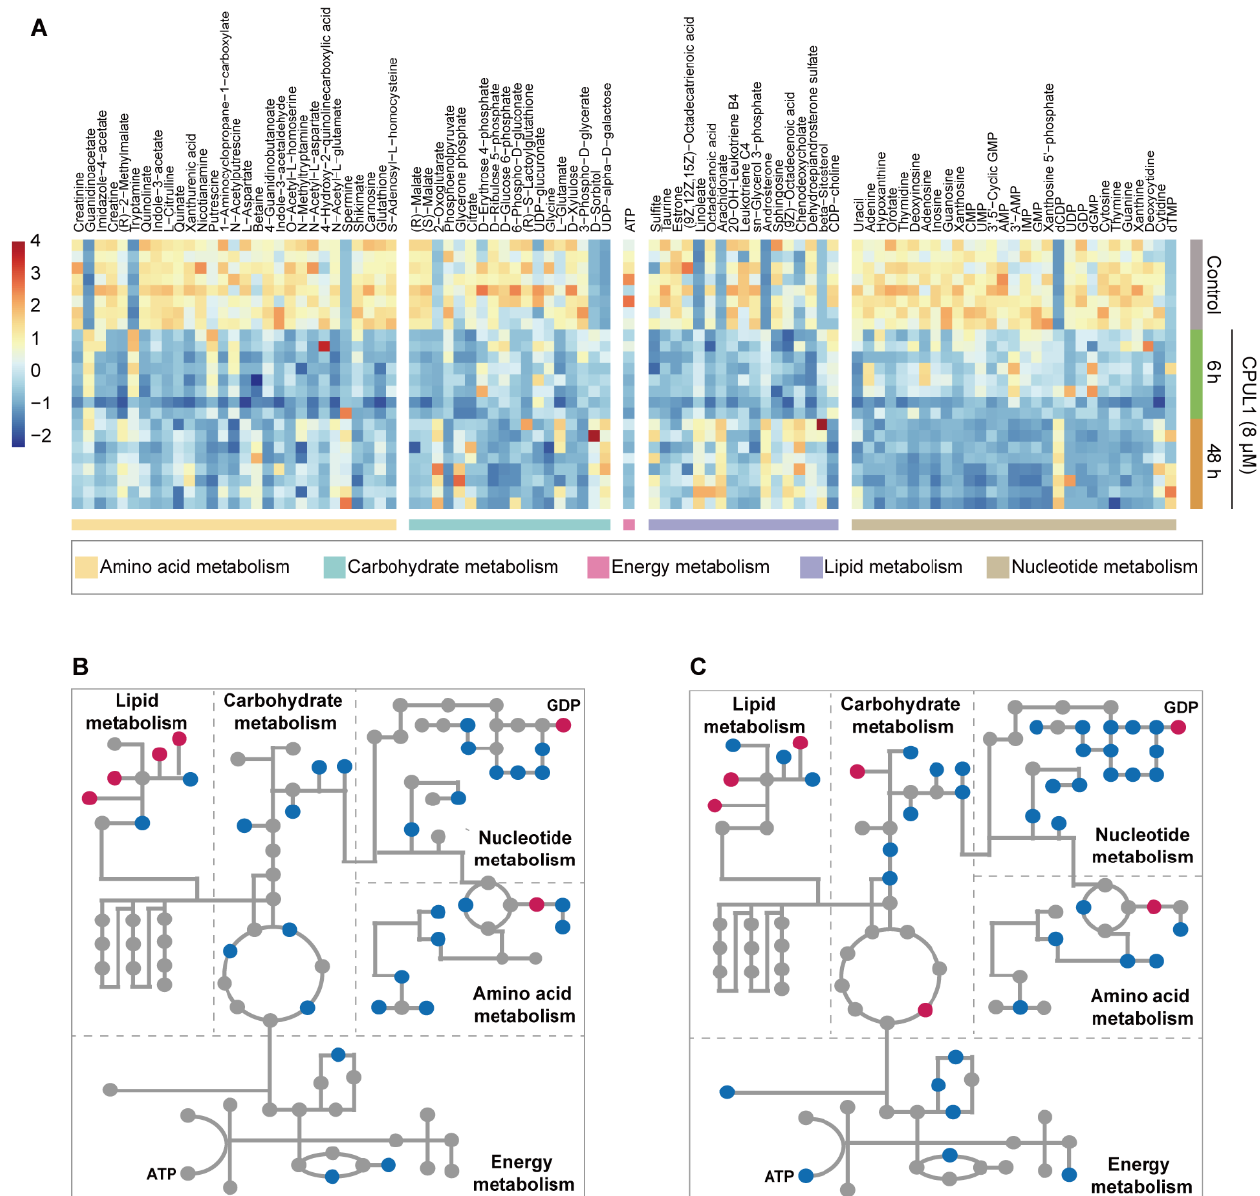
Figure 7. Differentially expressed endogenous metabolites enriched in the pathways. ( A ) The cluster heatmap of material metabolism-related metabolites identified for CPUL1 treatments and the control and the blue to the red color scale indicates the value of DAM expression. ( B ) Compounds with endogenous differences in the lipid, carbohydrate, nucleotide, amino acid, and energy metabolism under the exposure of 6 h-CPUL1-treatment. ( C ) Compounds with endogenous differences in the lipid, carbohydrate, nucleotide, amino acid, and energy metabolism under the exposure of the 48 h-CPUL1-treatment.